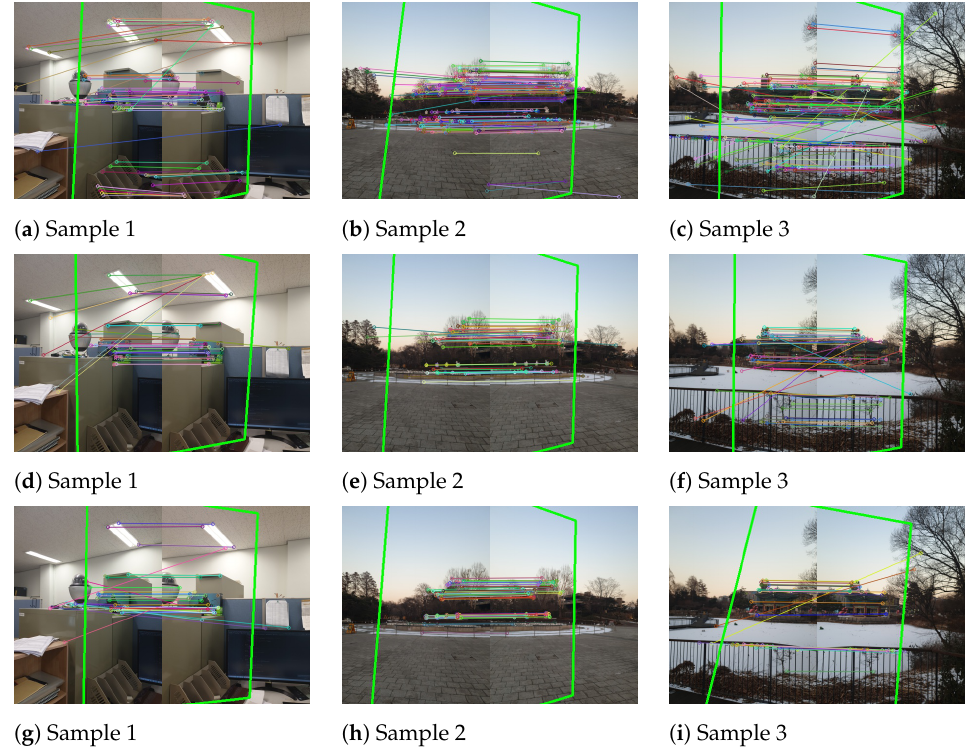
Figure 10. Three different image pairs were tested for overlap area detection with SIFT, AKAZE, and ORB: ( a – c ) show the overlap area detected by the SIFT algorithm in image pair 1, image pair 2, and image pair 3, respectively; ( d – f ) show the overlap area detected by the AKAZE algorithm in image pair 1, image pair 2, and image pair 3, respectively; and ( g – i ) show the overlap area detected by the ORB algorithm in image pair 1, image pair 2, and image pair 3, respectively.